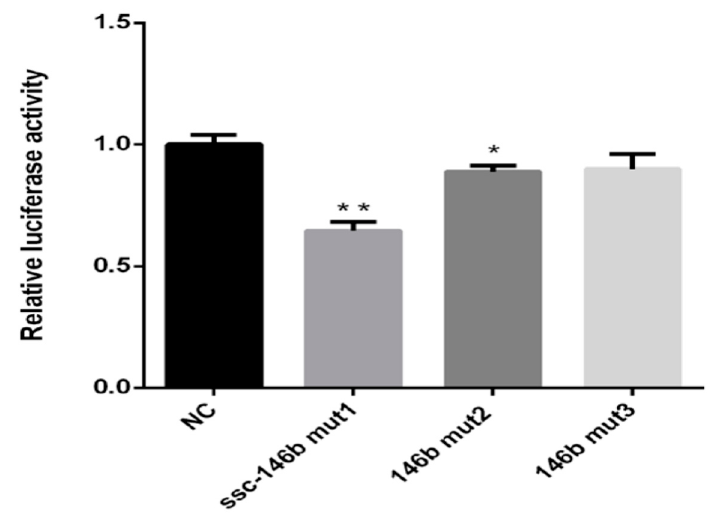
Figure 8. Analysis of end base mutation changes of miR-146b targeting on IRS1 by luciferasereporter assay ( n = 8, * p < 0.05 , ** p < 0.01).